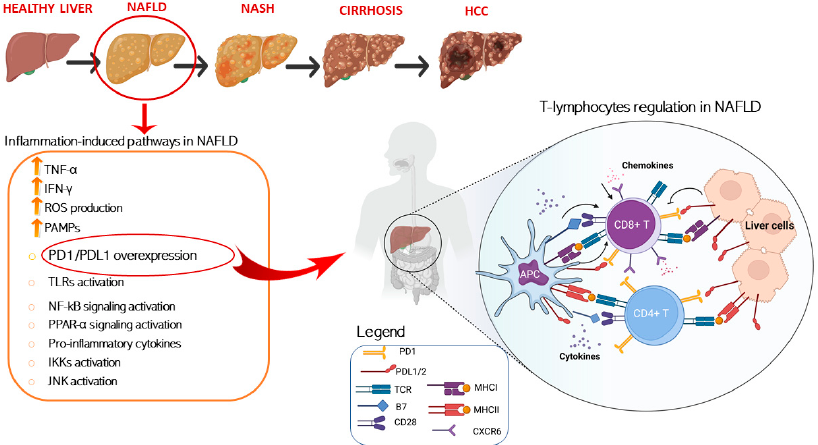
Figure 1. Schematic representation of T cells immune regulation and inflammation-induced pathways upon liver disease. Liver inflammation is a key factor in NAFLD pathogenesis and is